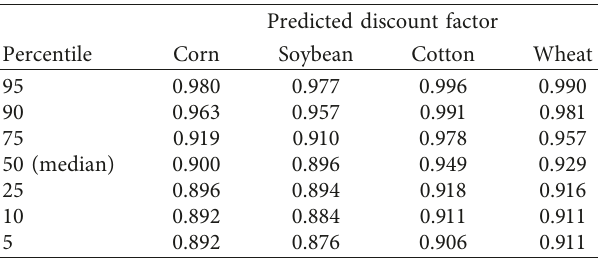
Table 1: Percentiles of predicted good experience insurance pre- mium discount factors for corn (maize), soybean, cotton,